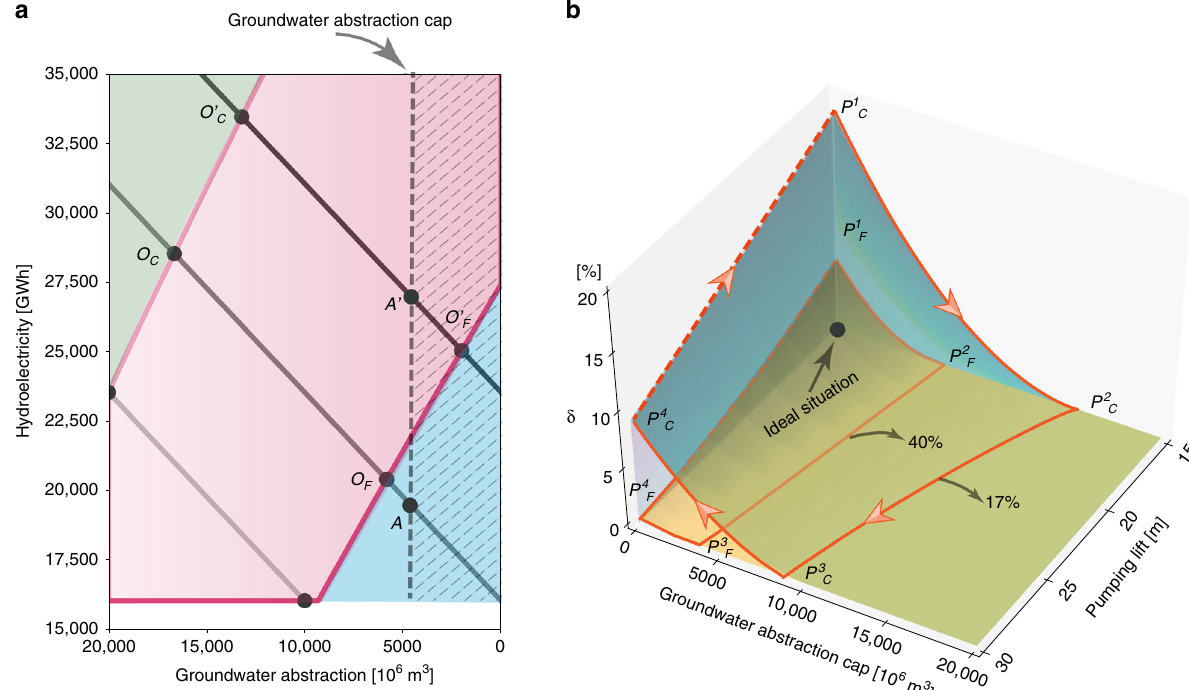
Fig. 2 Impact of regulation policy on groundwater – hydropower trade-offs. a Schematic illustration of how groundwater abstraction cap ( g Cap w ) shifts the trade-offs optimal point. O C = O 0 and O F = O 0 represent the optimal point given current (17%) and future (40%) penetration of SWE in the normal/wet year C F without g Cap w . The vertical dashed line sets the limit of groundwater abstraction to meet certain regulations. With such a water constraint, the optimal point can only fall into the hatched area. When surface water is not abundant (e.g., during a normal year), the optimal point O C = O F will not be attainable, and therefore A becomes the new optimal under the regulation. However, such regulation does not affect the optimal point ( O 0 during wet year) and when SWE penetration is high, as O 0 is still in the hatched area. b Relative revenue loss ( δ ) as a function of groundwater pumping lift F ( Δ h ) and g Cap w under the in fl uence of different penetration ratios of SWE (17% and 40%). Revenue loss zones are represented by the wedge-shaped area P 2 P 3 P 4 ; future: P 1 P 2 P 3 P 4 ). Dashed orange lines represent extremely strict regulation policy (e.g., zero allowance enclosed by the orange lines (current: P 1 C C C C F F F F